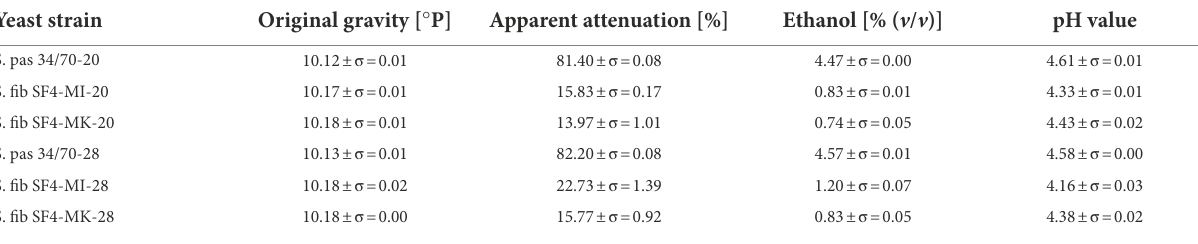
TABLE 4 Original gravity [%], apparent attenuation [%], ethanol content [% ( v / v )], and pH values in the final beers fermented with the yeast strain S. fibuligera S. fib SF4 (mother culture and micromanipulated culture) and the reference yeast strain S. pastorianus S. pas 34/70 at fermentation temperatures of 20 and 28 ° C.